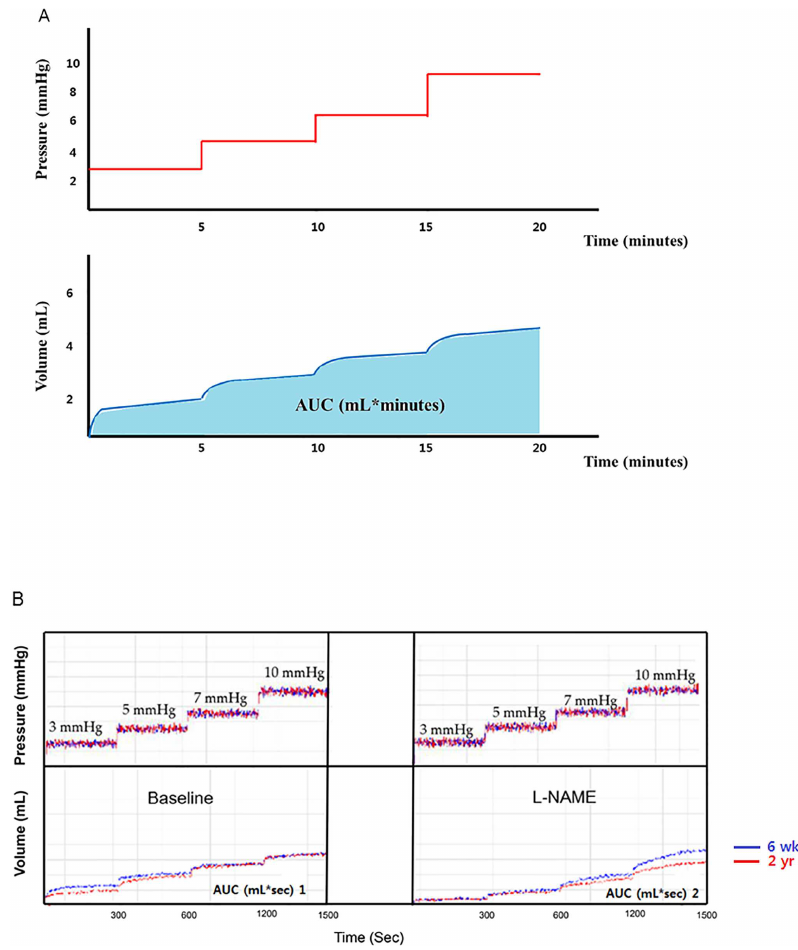
Fig 3. Measurement of the change in gastric accommodation. (A) The pressure-dependent volume curve obtained by applying3, 5, 7, and 10 mmHg at 5 minute intervals was measuredin each aged rat group. The changeof volume and area under curve (AUC) of the pressure-dependentvolume was measuredin each group to obtainthe pressure-related volume (mL) * time (sec) in the tonic phase. (B) To analyzethe gastric accommodation in each aged rat group, we comparedwith the pressureassociatedvolume changeand baselineAUC (mL * sec)of the aged rat groups. Afterwards, we comparedthe changein AUC ( Δ AUC: AUC 2 —AUC 1) after administering L-NAME to analyzethe responseof nNOS activity with age indirectly. The blue and red lines in the graph represent the pressureand volume curves of the 6-wk- and 2-yr-old rats.